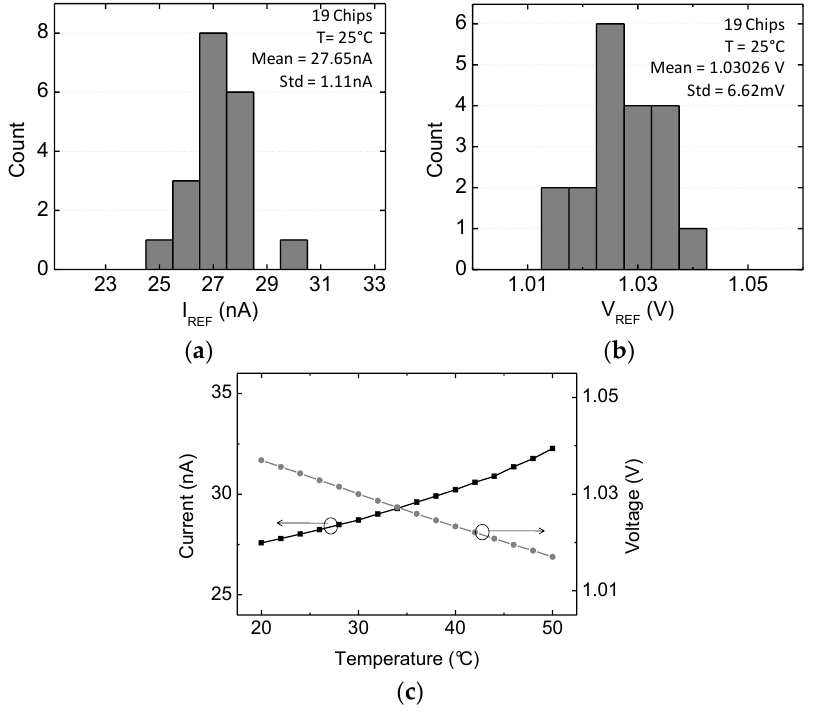
Figure 19. Measured variations of ( a ) reference current, and ( b ) reference voltage. ( c ) Variation of reference current and voltage as a function of temperature.